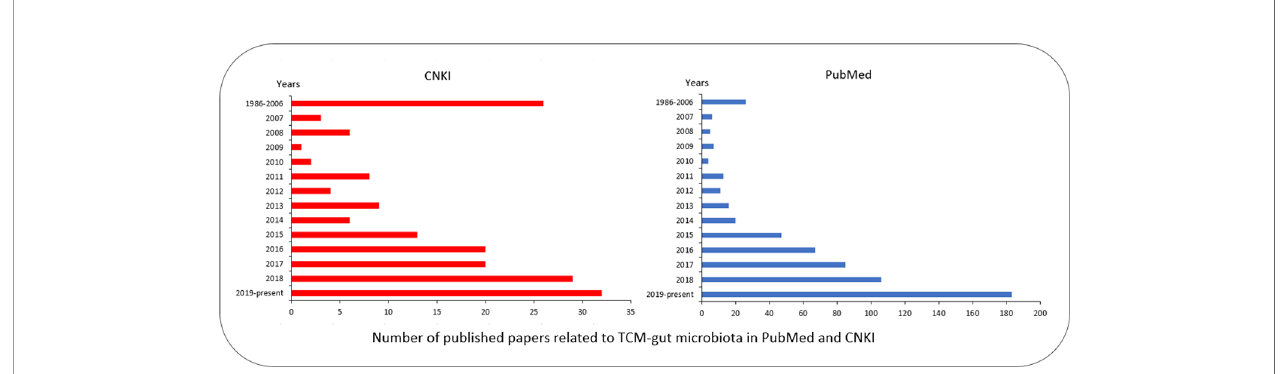
FIGURE 2 | Number of published papers related to TCM-gut microbiota in PubMed and CNKI. Papers in PubMed were searched using keywords “ gut/intestinal microbiota, ” “ Chinese, ” and “ medicine ” ; Papers in CNKI were searched by Chinese name of “ TCM ” and “ gut microbiota/microbiome. ” The red bar chart represents the papers in Chinese; the blue bar chart represents the papers